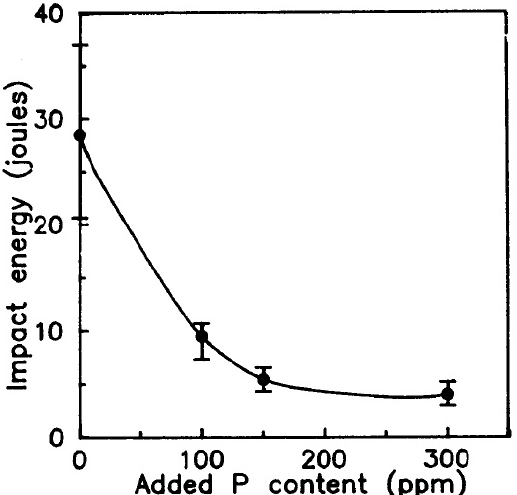
Figure 8. Effect of P on the impact energy of 93W-4.9Ni-2.1Fe [67]. Reproduced with permission from Hong et al., Metallurgical Transactions A; published by Springer, 1991.